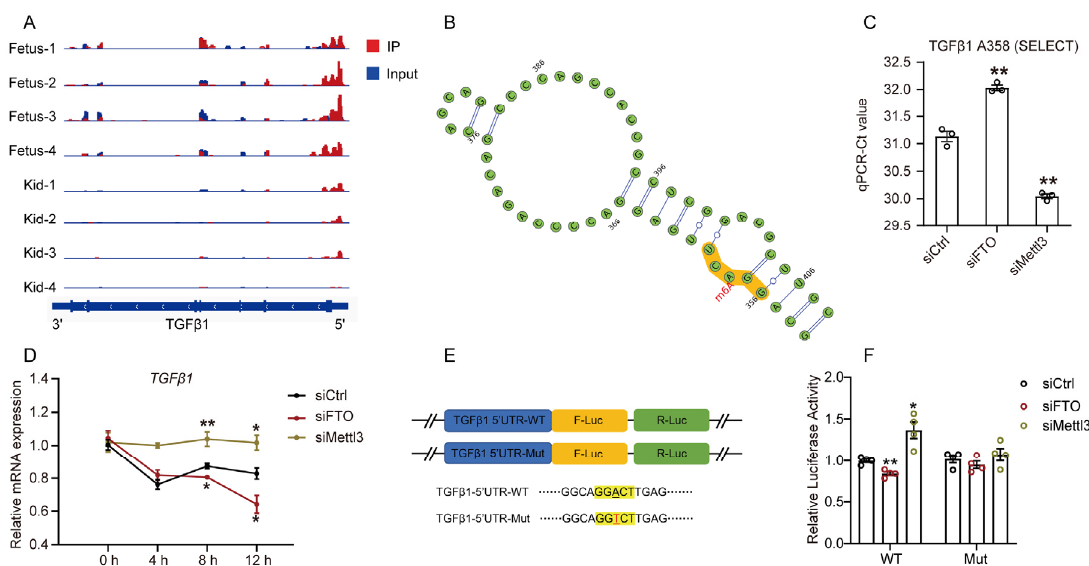
Figure 5. m 6 A promotes TGF β 1 mRNA decay: ( A ) The m 6 A abundance in TGF β 1 mRNA transcripts in skeletal muscle from fetuses and kids, as detected by analyzing m 6 A RIP-seq database; ( B ) m 6 A sites in 5 ′ UTR (A358) of TGF β 1 were predicted by SRAMP (http://www.cuilab.cn/sramp); ( C ) The Ct of qRT-PCR representing SELECT results for detecting m 6 A level in the potential m 6 A site of TGF β 1 5 ′ UTR (A358) in GPMs transfected with siFTO or siMettl3; ( D ) After treatment with actinomycin D to inhibit transcription, the mRNA stability of TGF β 1 in siCtrl, siFTO, and siMettl3 cells was quantitated by qRT-PCR; ( E ) Schematic representation of wild and mutated 5 ′ UTR of pmirGLO vector to investigate the roles of m 6 A in 5 ′ UTR in TGF β 1 expression; ( F ) Relative luciferase activity of wild-type or mutant pmirGLO-TGF β 1-5 ′ UTR reporter in GPMs transfected with siFTO or siMettl3. The data were obtained from at least three independent experiments. Results are expressed as mean ±SEM; * p < 0.05, ** p < 0.01.